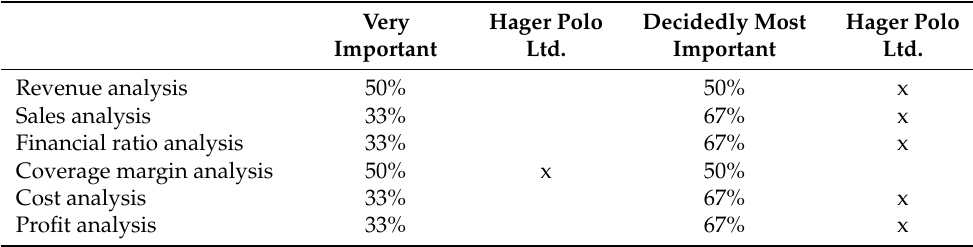
Table 4. Assessment of the management accounting system data facilitating decision making.